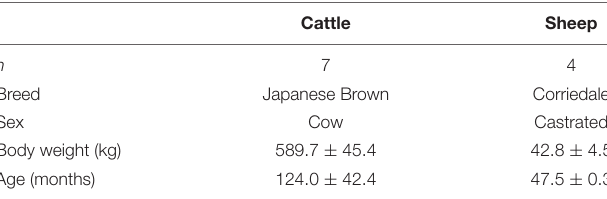
TABLE 1 | Characteristics of tested animals in the present